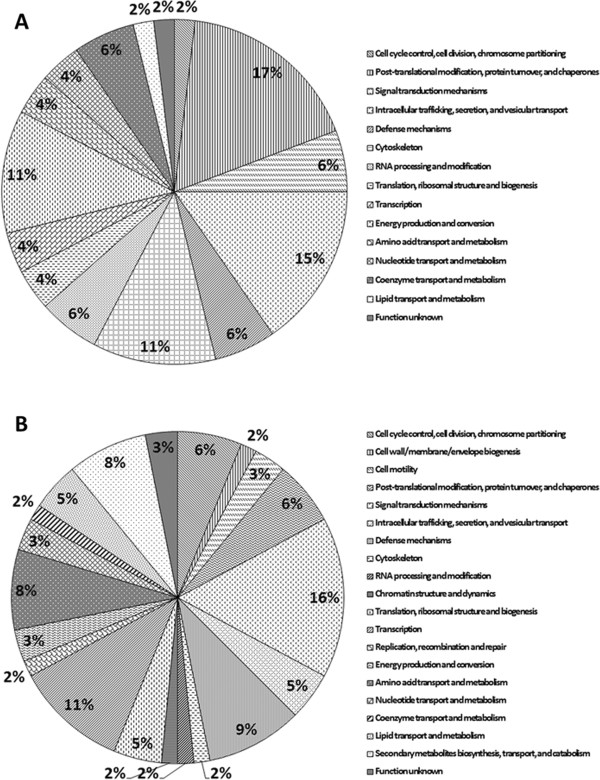
Clusters of Orthologous Groups (COGs) classification of identified proteins in A549 cells treated with (a) aqueous 
Phyllanthus 
extracts and (b) methanolic 
Phyllanthus 
extracts.